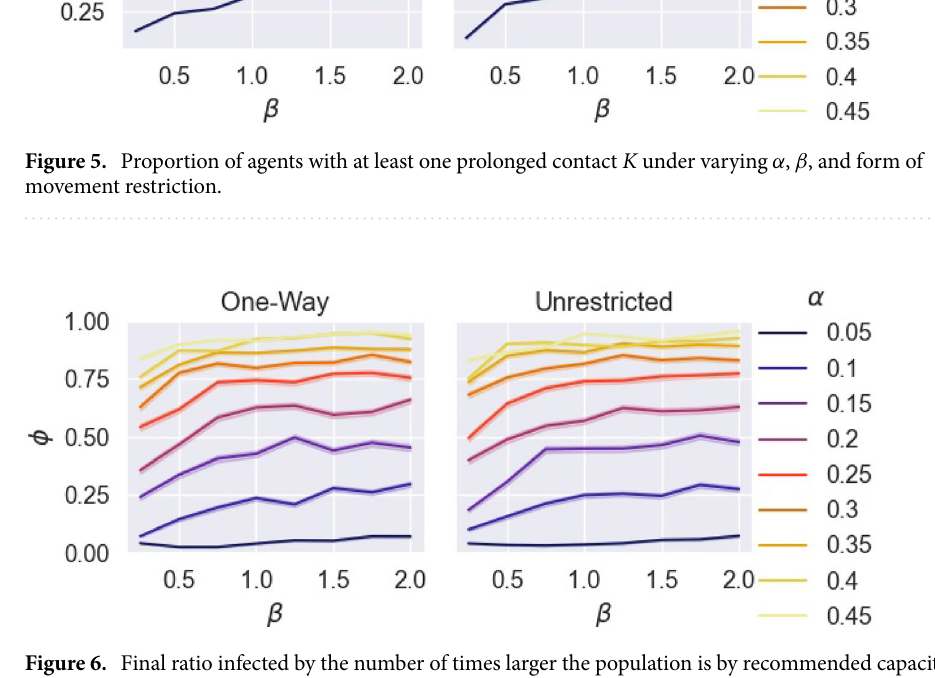
Figure 6. Final ratio infected by the number of times larger the population is by recommended capacity, by hourly break probability, for one-way and unrestricted